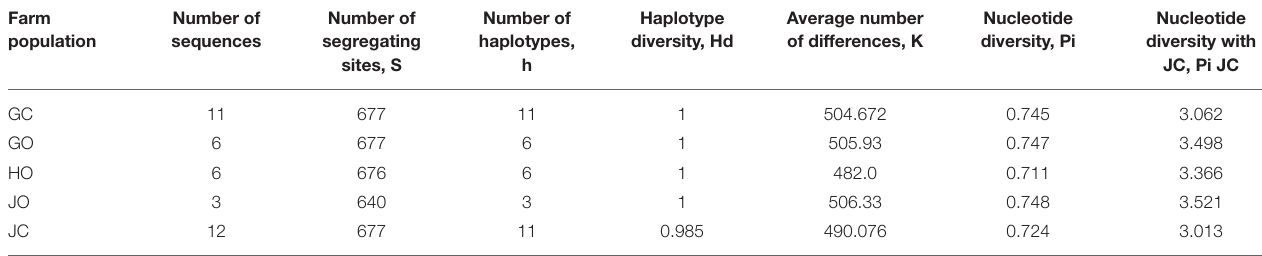
TABLE 7 | Analysis of molecular variance (AMOVA) of nodule isolates obtained from organic and conventional farms. Source of variation